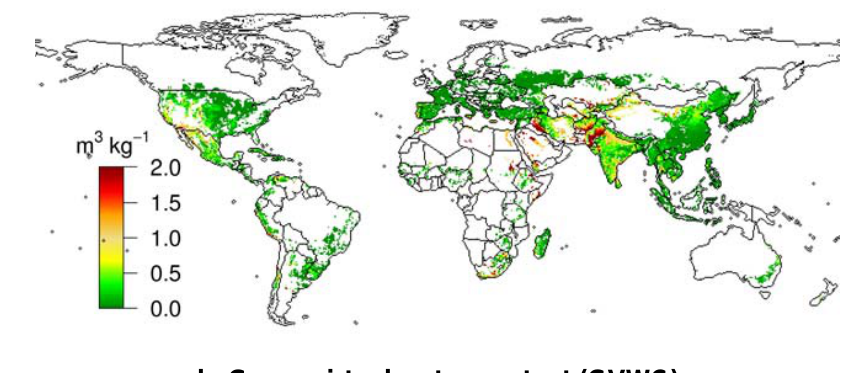
Paraguay, Argentina, Uruguay and Canada use more than 50 % of their current (green and blue) water consumption to produce export goods; in the case of Australia, Cyprus and Oman it is more than 70 % (data not